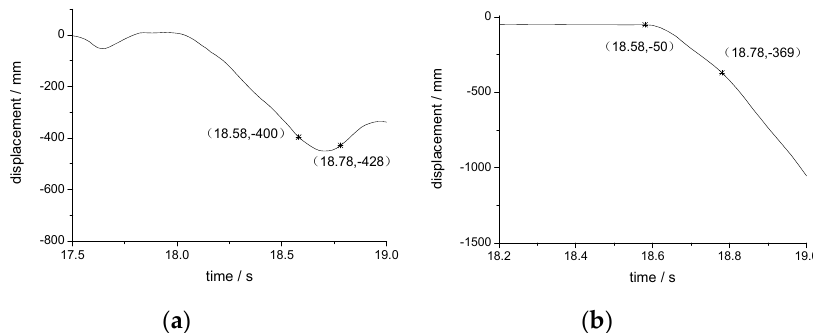
Figure 29. Time history curve of the CLUC system: ( a ) relative displacement of side pier and girder; ( b ) vertical displacement at the end of the main girder.